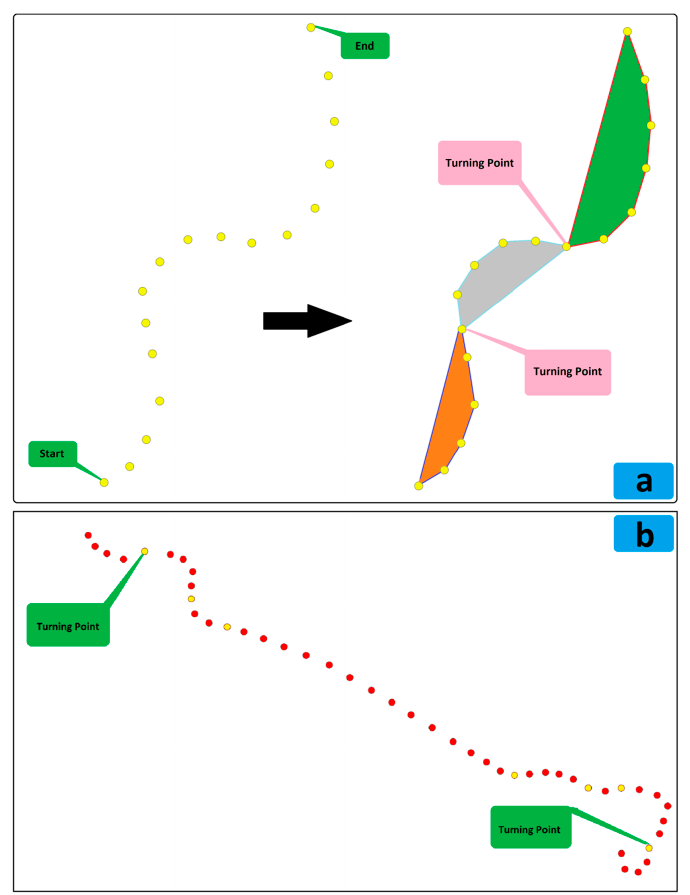
Figure 10. Turning points of a trajectory. ( a ) Two turning points at the intersection of some Convex Hulls; ( b ) Generalisation of turning points at the intersection of several Convex Hulls.